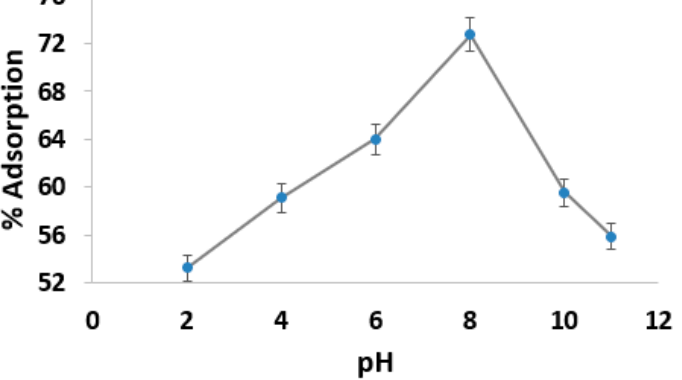
Figure 2. Effect of pH on the percentage of As(III) adsorption. Error bars represent the standard error from triplicate experiments.